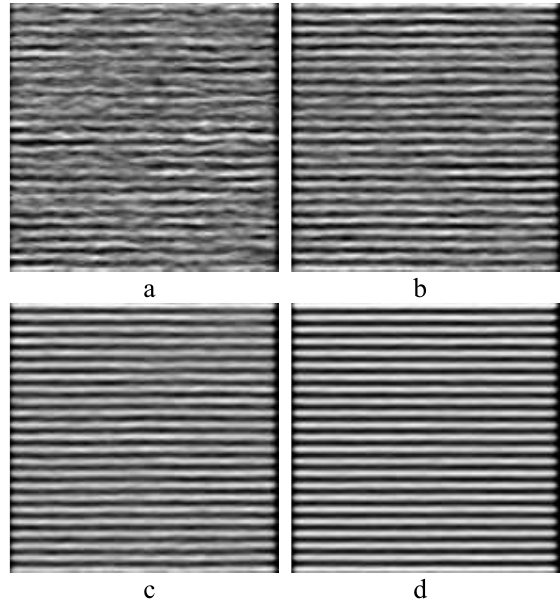
Figure 2. Effect of the exposure time on the efficiency of reconstruction of the object structure in anisoplanar turbulence. The conditions are Figure 1. Effect of the exposure time on image similar to those in Fig. parameters in anisoplanar turbulence. The = 9.6, where observation range z = 0.05 ka t2 ; D / r 0 N D = 2 a t . pix = 512; averaging over (a) 1, (b) 5, (c) 20, and (d) 100 realizations of short-exposure images.